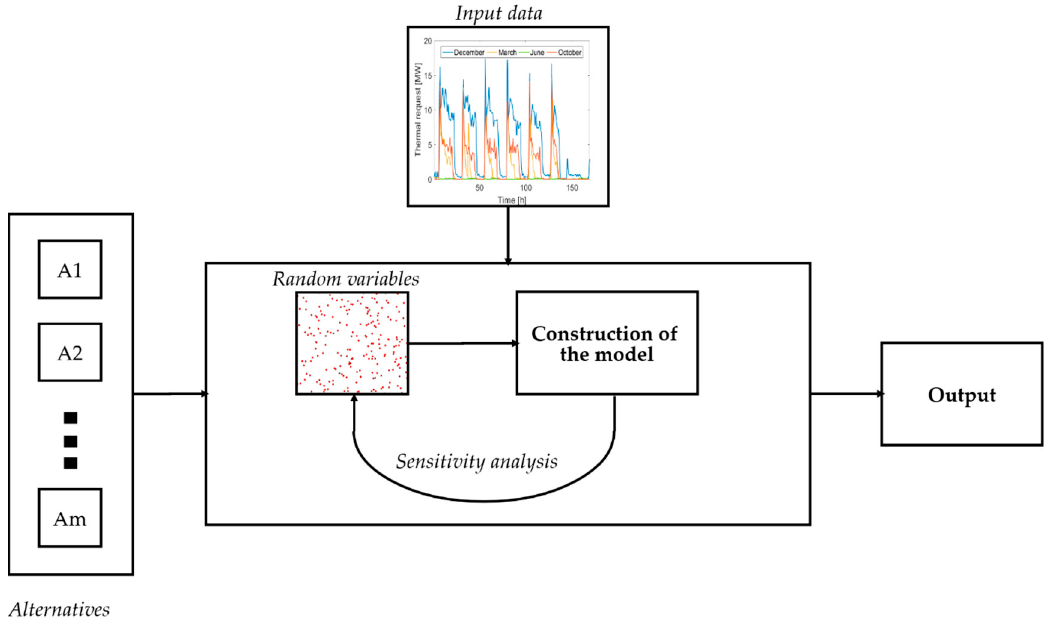
Figure 1. Framework of the proposed methodology (Stage 1): Construction of the energy model, uncertainties and dependencies analysis for each alternative.